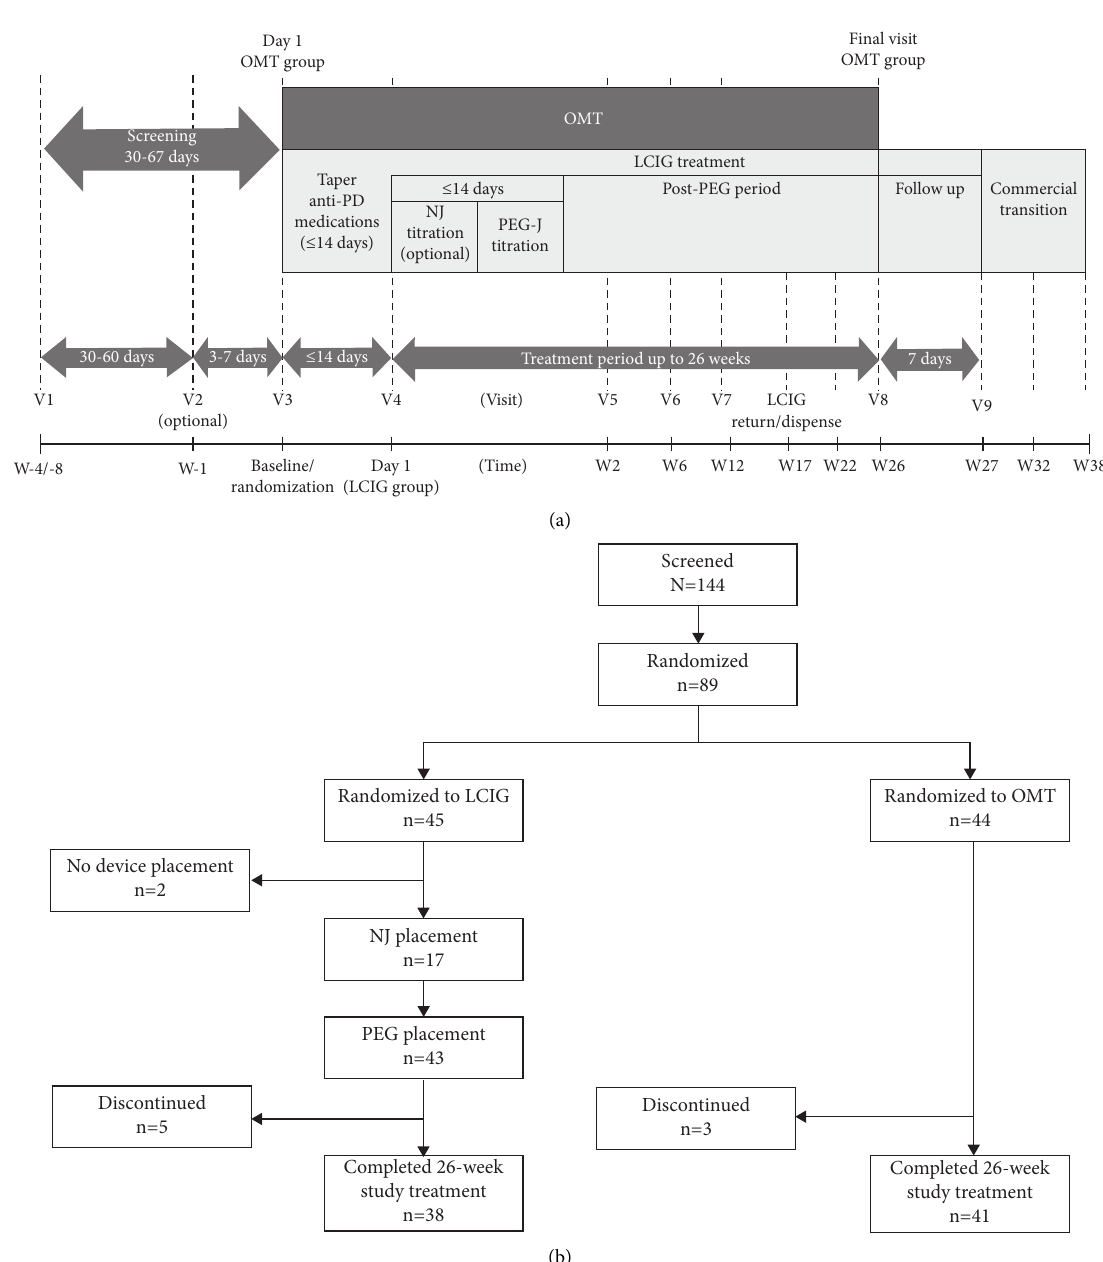
Figure 1: Study design (a) and patient fow diagram (b). Abbreviations: Anti-PD: anti-Parkinson’s disease, LCIG: levodopa-carbidopa intestinal gel, NJ: nasojejunal, OMT: optimized medical treatment, PEG-J: percutaneous endoscopic gastronomy with jejunal extension, V : visit, and W :